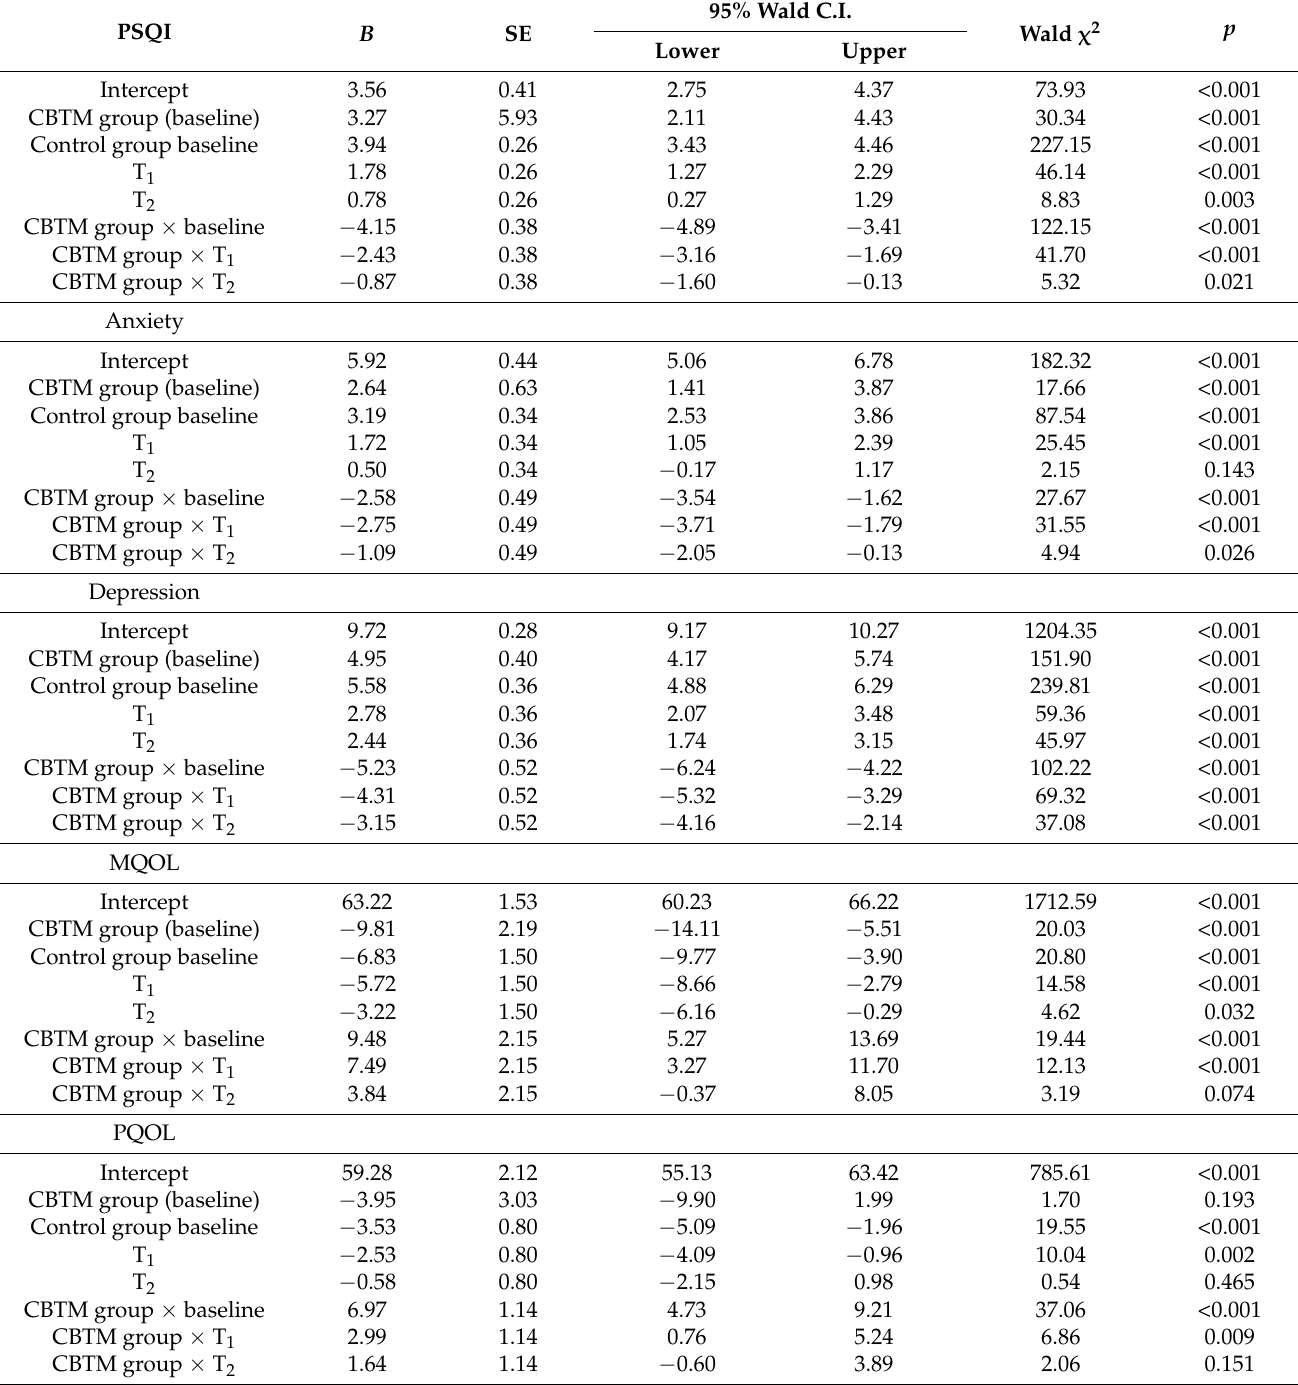
Table 3. Effects of the CBTM on Patient’s PSQI, Anxiety, Depression, and PQOL, & MQOL in the Before, Post-Intervention (T1), 1-Month (T2), and 3-Month (T3) Follow-up ( n =